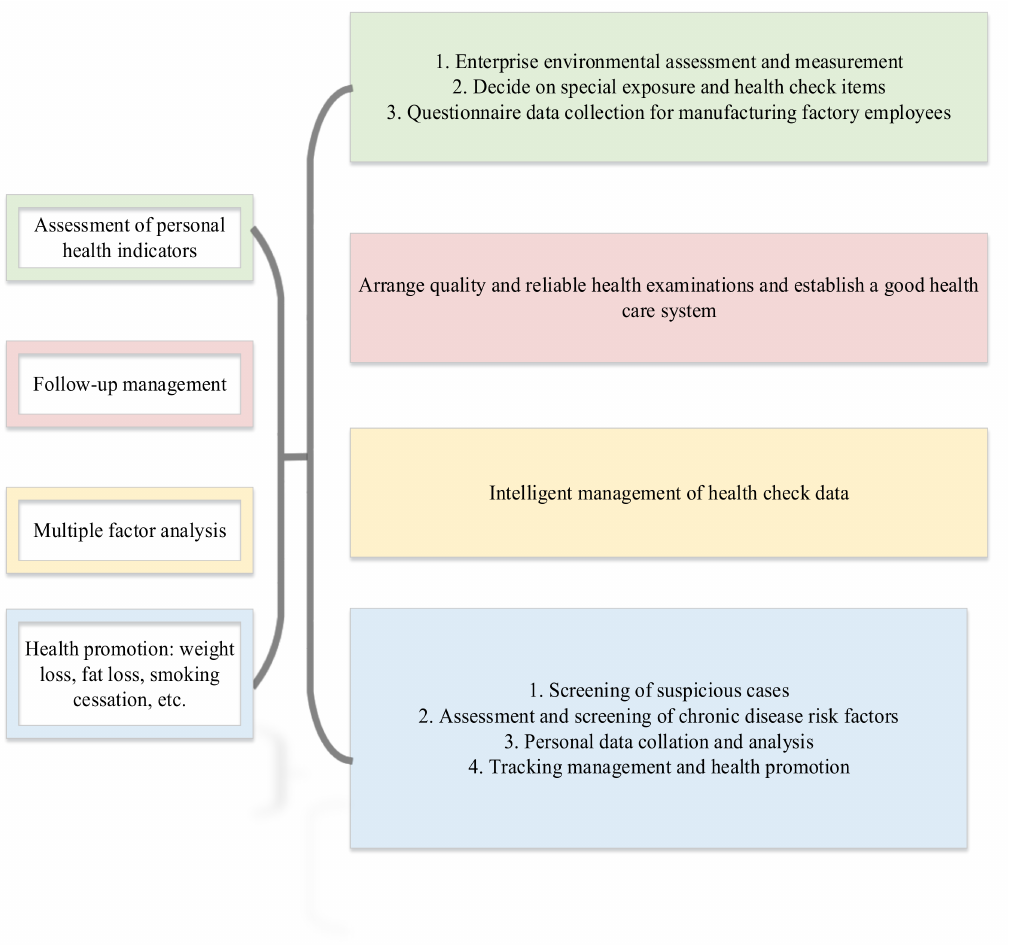
Figure 4. Process of WHSM in manufacturing